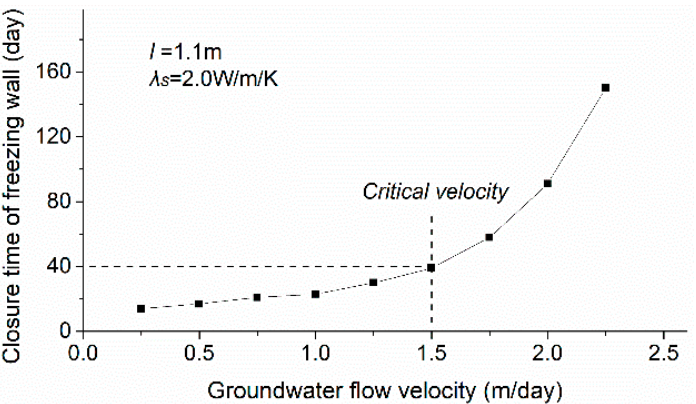
Figure 6. Closure times of freezing wall with various groundwater flow velocities and definition of the